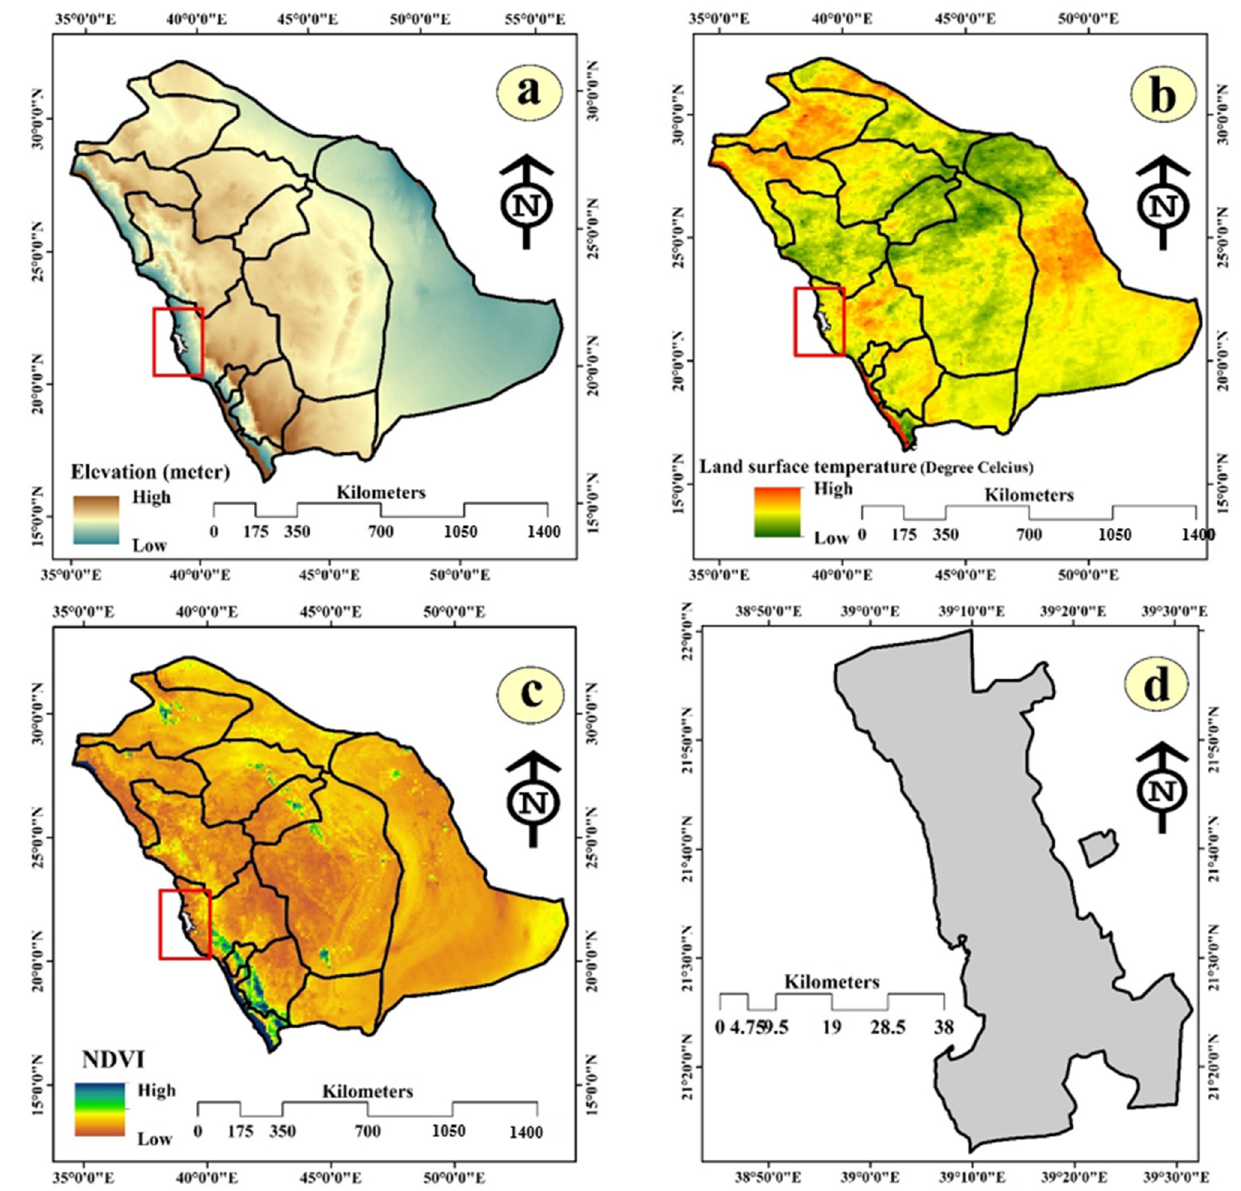
Figure 2. Location of Jeddah city within Saudi Arabia ( a ); elevation map; ( b ) land surface temperature map; ( c ) NDVI map and; ( d ) Jeddah city. Table 1. Profile of the Jeddah city.